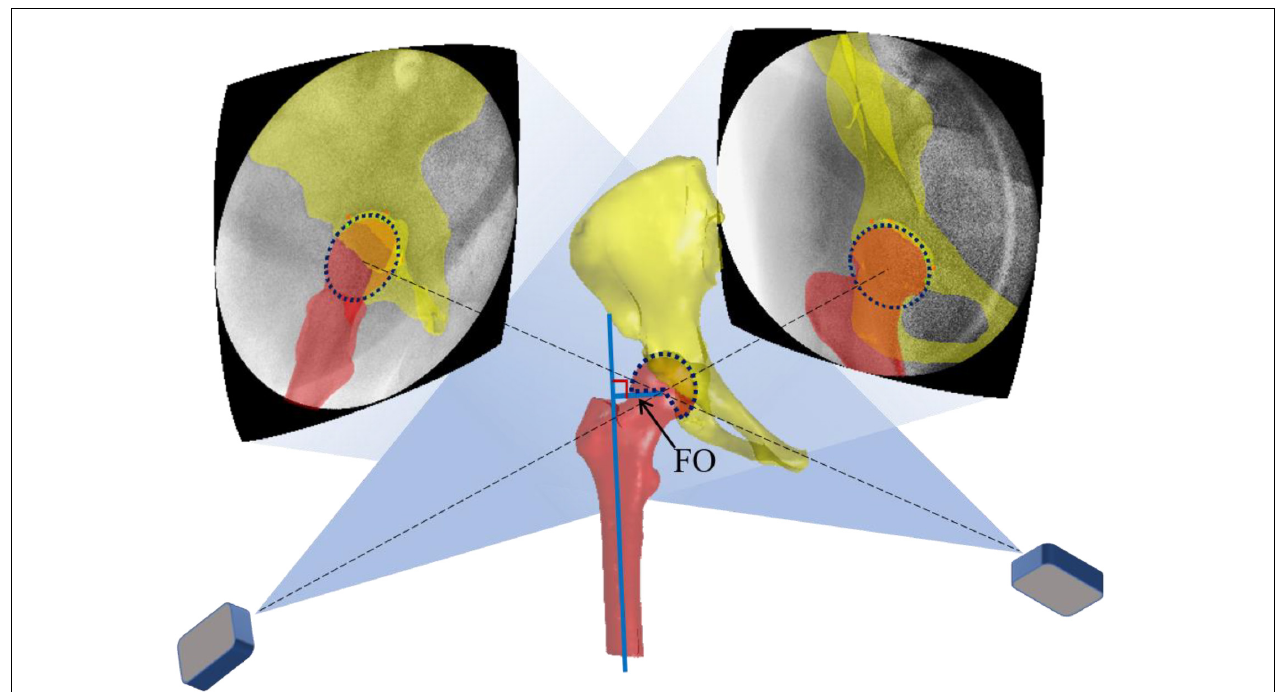
FIGURE 1 | A virtual DFIS environment is constructed following the projection parameters obtained from the calibration procedure. The two-projection line intersection from two X-ray sources to the hip joint center determines the 3D skeletal models’ position. The FO was defined as the perpendicular distance from the femoral head’s rotation center to the femoral long